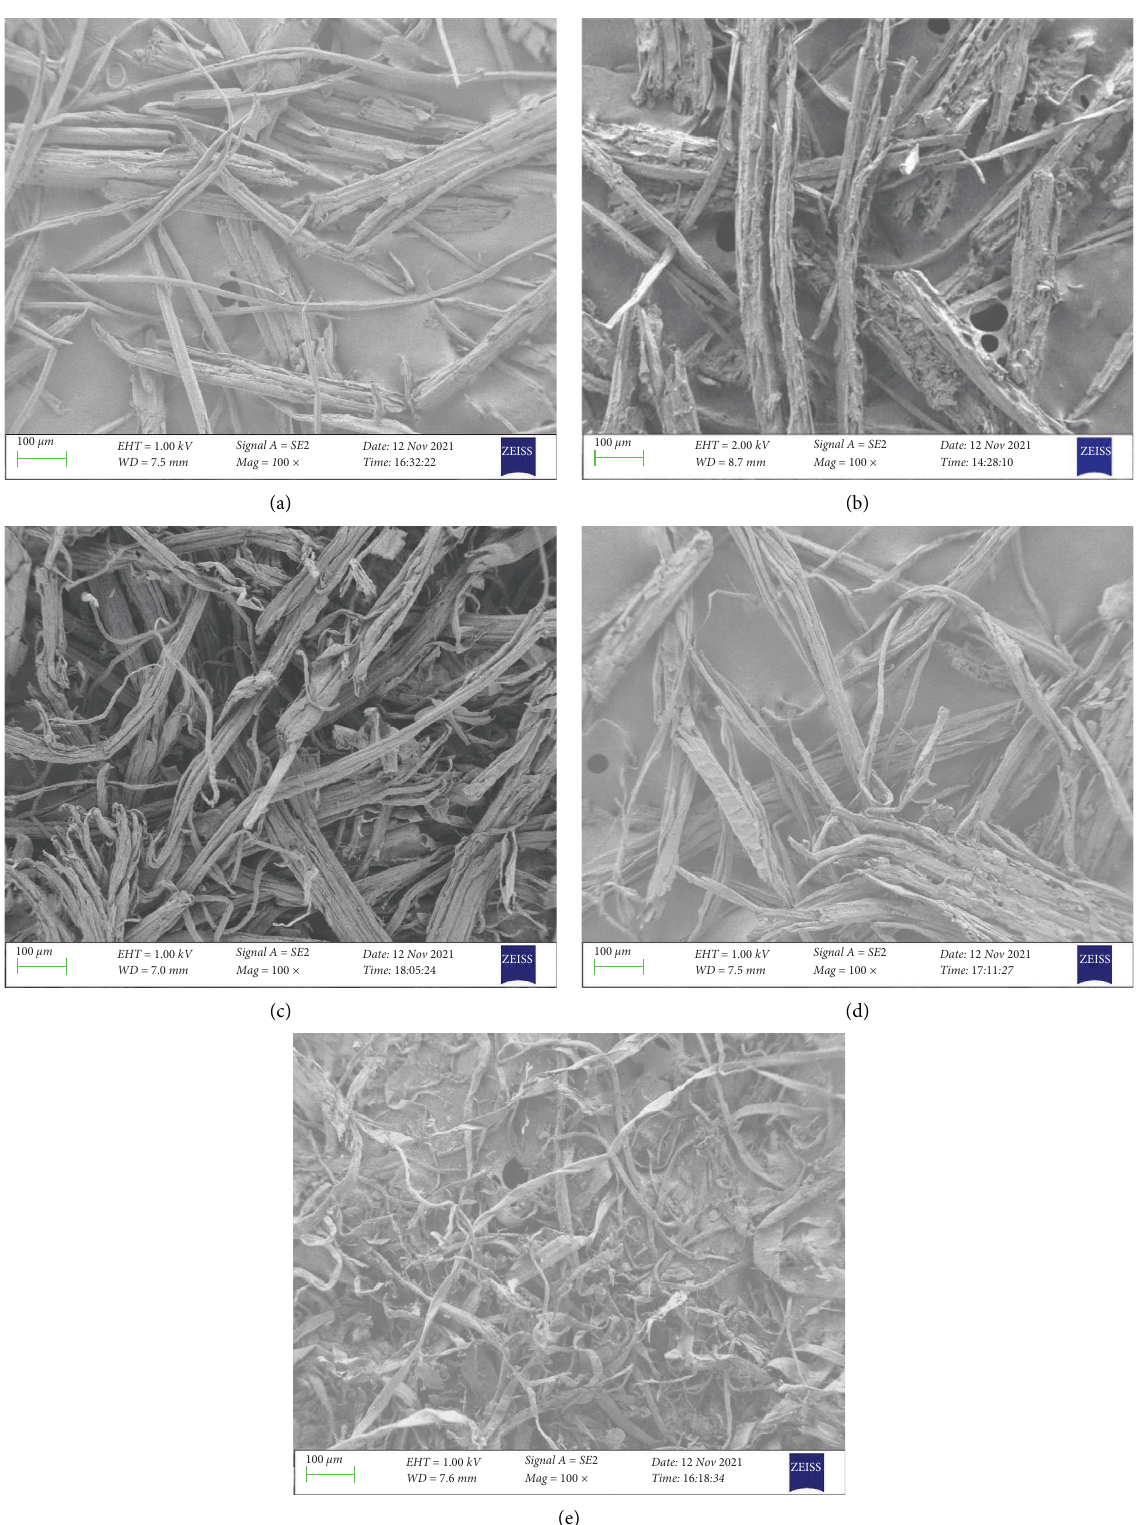
Figure 11: Microscopic view of fber at 100x. (a) Corn straw fber. (b) Cotton straw fber. (c) Modifed corn straw fber. (d) Modifed cotton straw fber. (e) Lignin